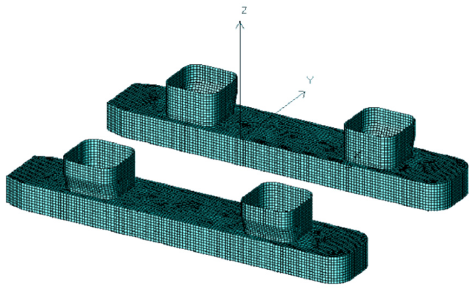
Figure 4. The panel model of the semi ‐ submersible platform for boundary element method (BEM) calculation in AQWA software.